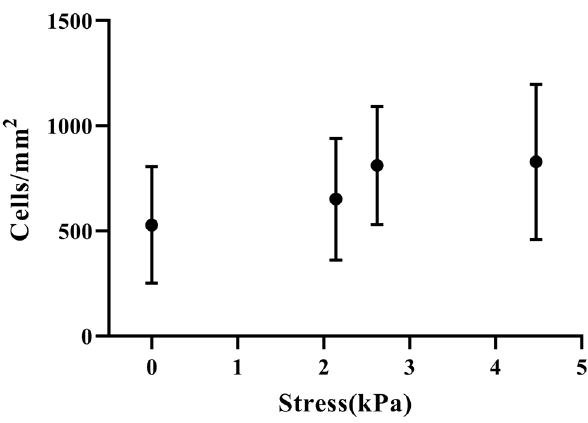
Figure 7: Cell density relationships with stress in di ff erent bone structures. The cell density values corresponding to each stress level were expressed in terms of mean and standard